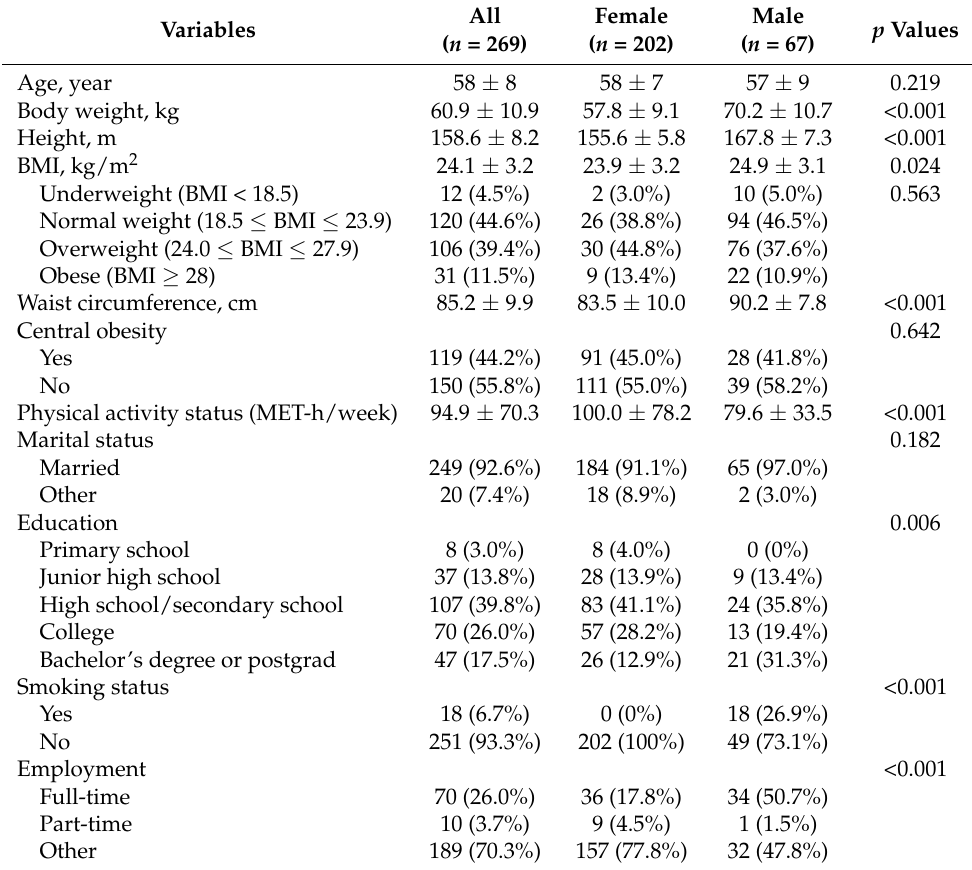
Table 1. Characteristics of 269 Chinese participants with hyperlipidemia according to gender 1,2